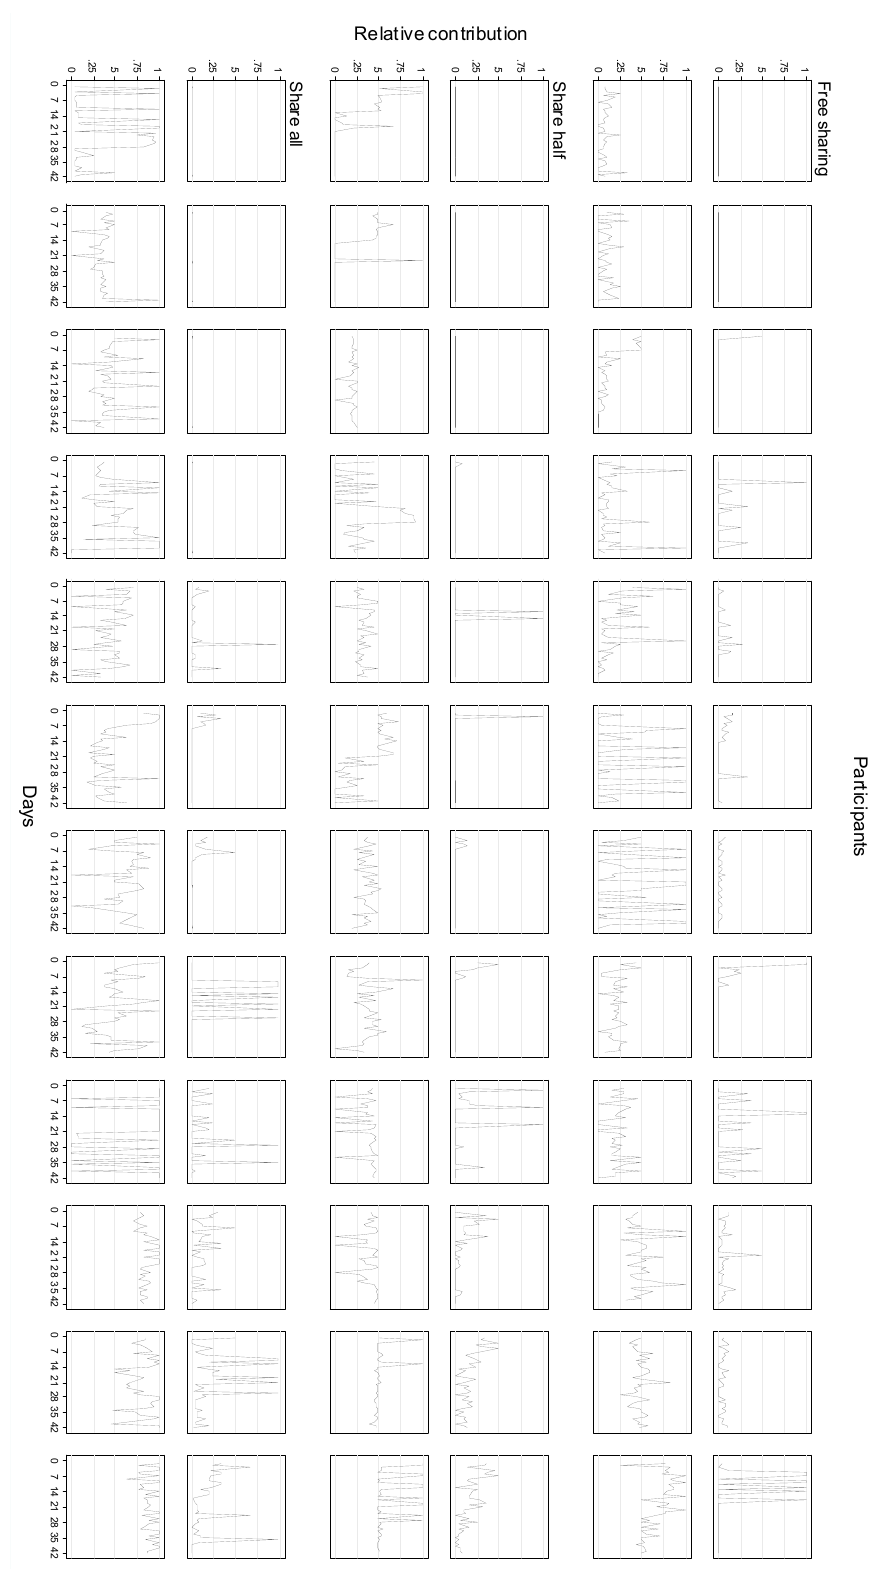
Figure A2. Each graph plots a waiter’s relative contribution over the 42 days. The first two rows belong to Free Sharing rule, the third and fourth row to Share Half and the last two rows to Share all. Groups are ordered according to their mean contributions. Within a group, participants within each sharing rule are ordered according to their mean contribution.